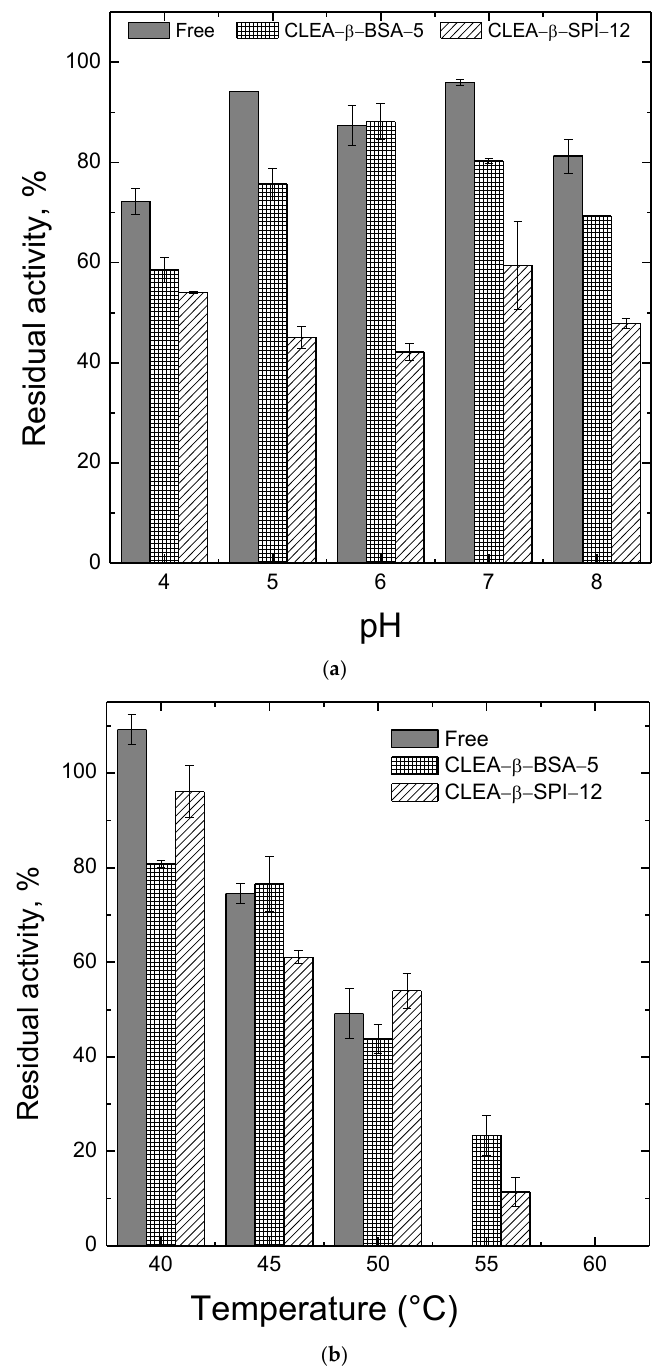
Figure 3. Residual activities of free β-amylase, CLEA-β-BSA-5 and CLEA-β-SPI-12 for pH stability ( a ) after 12 h of incubation at 25 °C and temperature stability and, ( b ) after 12 h of incubation at pH 6.0 (CLEA-β-BSA-5) and pH 7.0 (free β-amylase and CLEA-β-SPI-12). 100% is the initial activity.